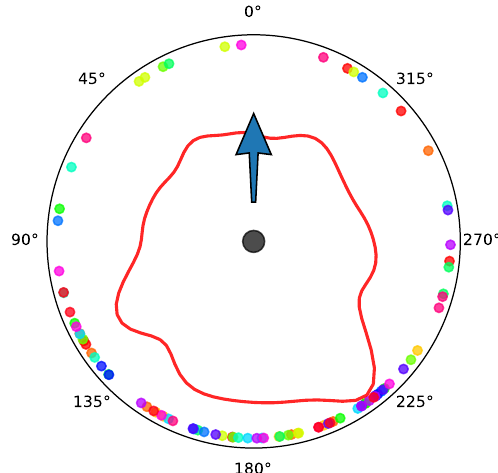
Figure A1. Directions of target objects in scenes relative to the observer’s starting directions (blue arrow pointing north) after collapsing the up axis (view from above). The dots represent individual target objects, their color refers to the scene they belong to. The polar density distribution of directions (cid:116) (cid:116) (cid:116) is shown as a red curve (estimated with a von Mises kernel). Color-to-scene legend: B01, B02, B03, (cid:116) (cid:116) (cid:116) (cid:116) (cid:116) (cid:116) (cid:116) (cid:116) (cid:116) (cid:116) (cid:116) (cid:116) (cid:116) K01, K02, K03, L01, L02, L03, O01, O02, O03, O04, S01, S02, S03 (where B means bathroom , K means kitchen , L means living-room , O means office and S means bedroom ).